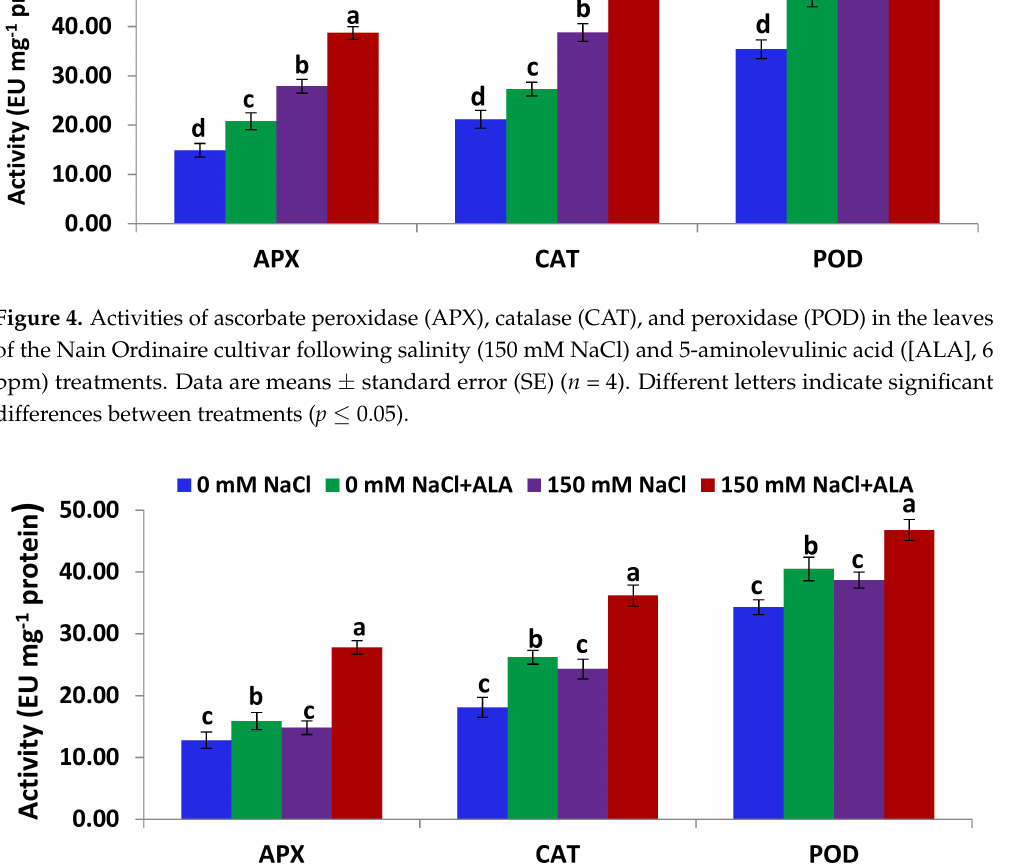
Figure 5. Activities of APX, CAT, and POD in the leaves of the Elatius 3 cultivar following salinity (150 mM NaCl) and 5-aminolevulinic acid ([ALA], 6 ppm) treatments. Data are means ± SE ( n = 4). Different letters indicate significant differences between treatments ( p ≤ 0.05).